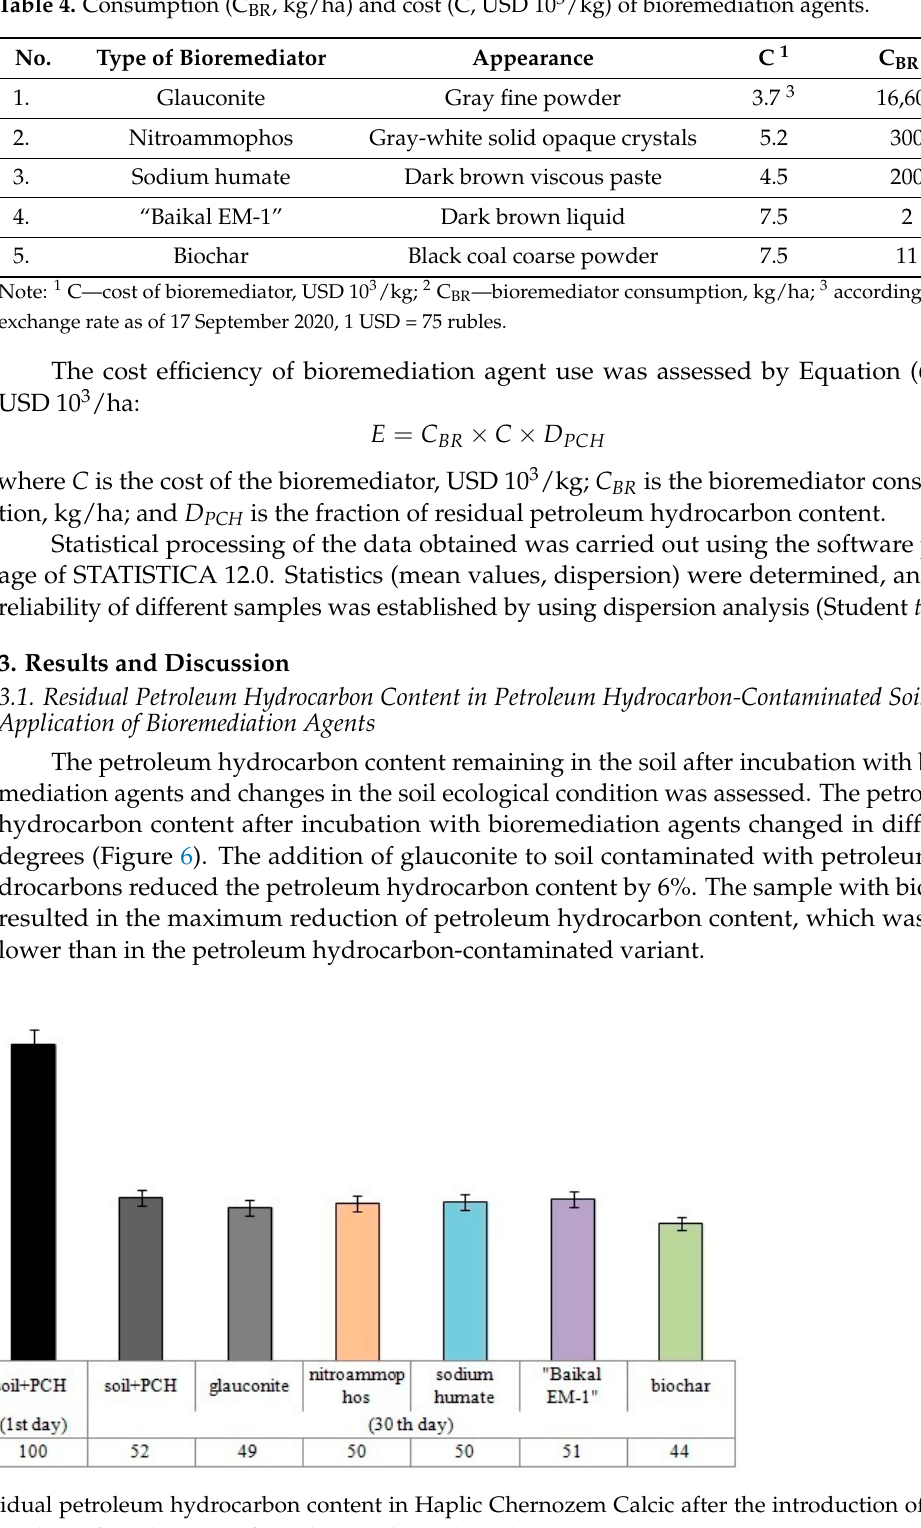
Table 4. Consumption (C BR , kg/ha) and cost (C, USD 10 3 /kg) of bioremediation agents.